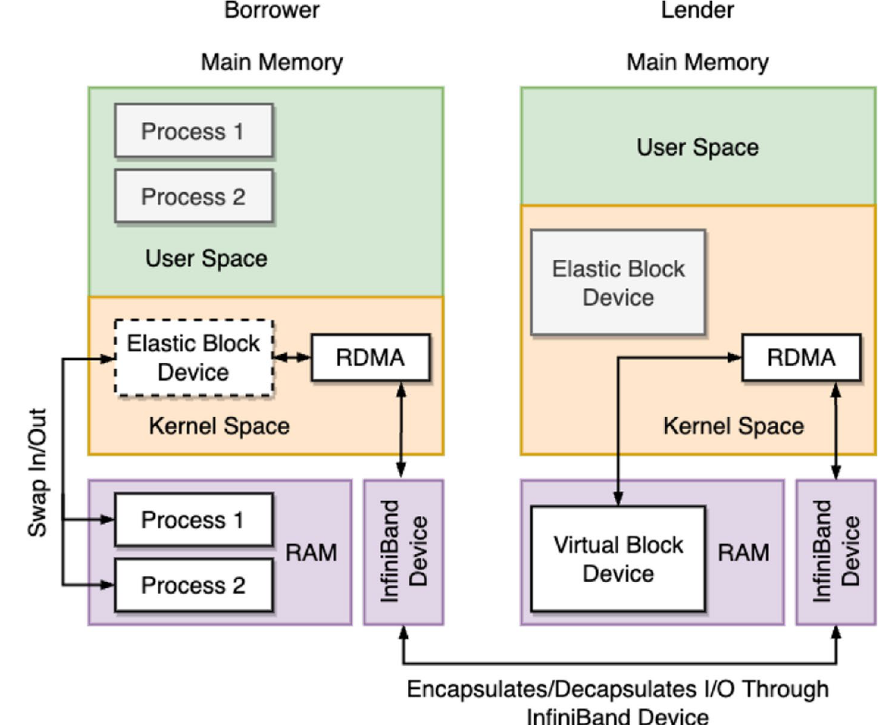
Fig. 2 System swap diagram in our memory sharing